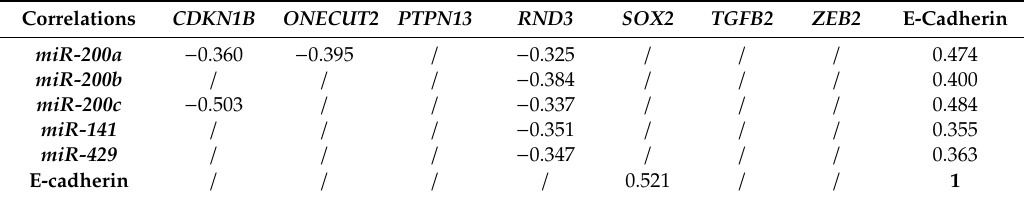
Table 3. Statistically significant correlations between expression of miR-200 family and their target genes and association with E-cadherin